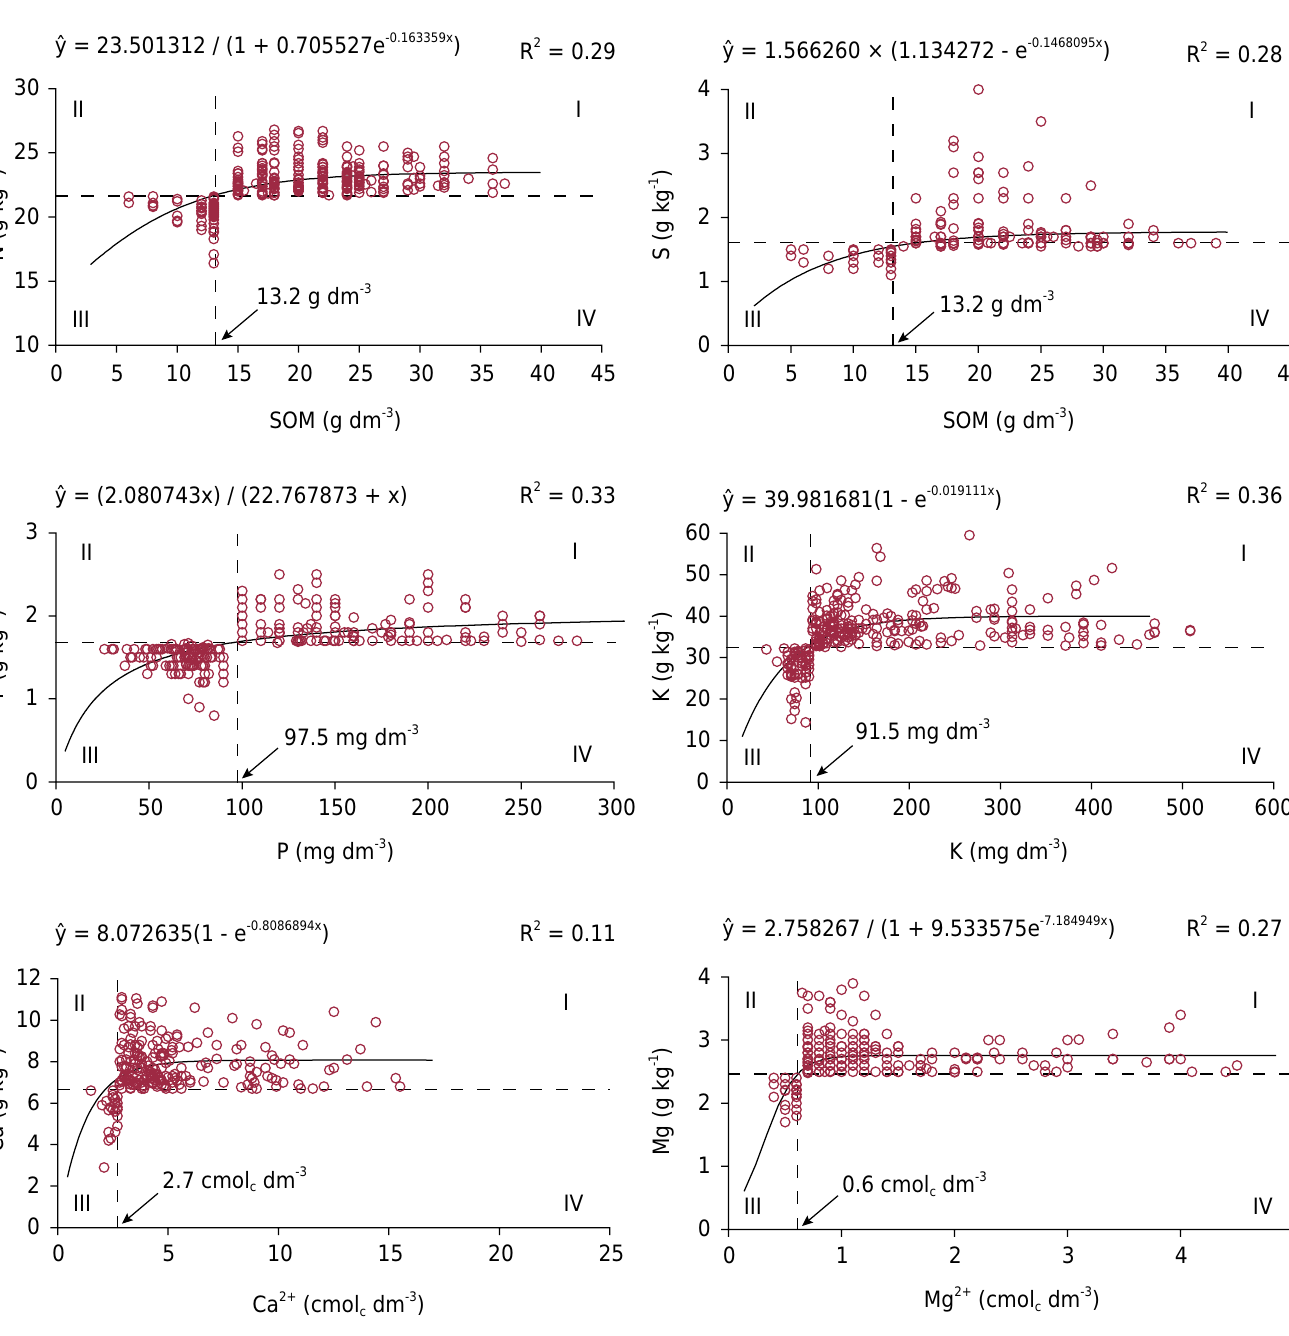
Figure 5. Contents of nutrients in the diagnostic leaf of the banana tree, as a function of the contents of organic matter and macronutrients in the soil, obtained by the Quadrant Diagram of the Plant-Soil Relationship (QDpsR)